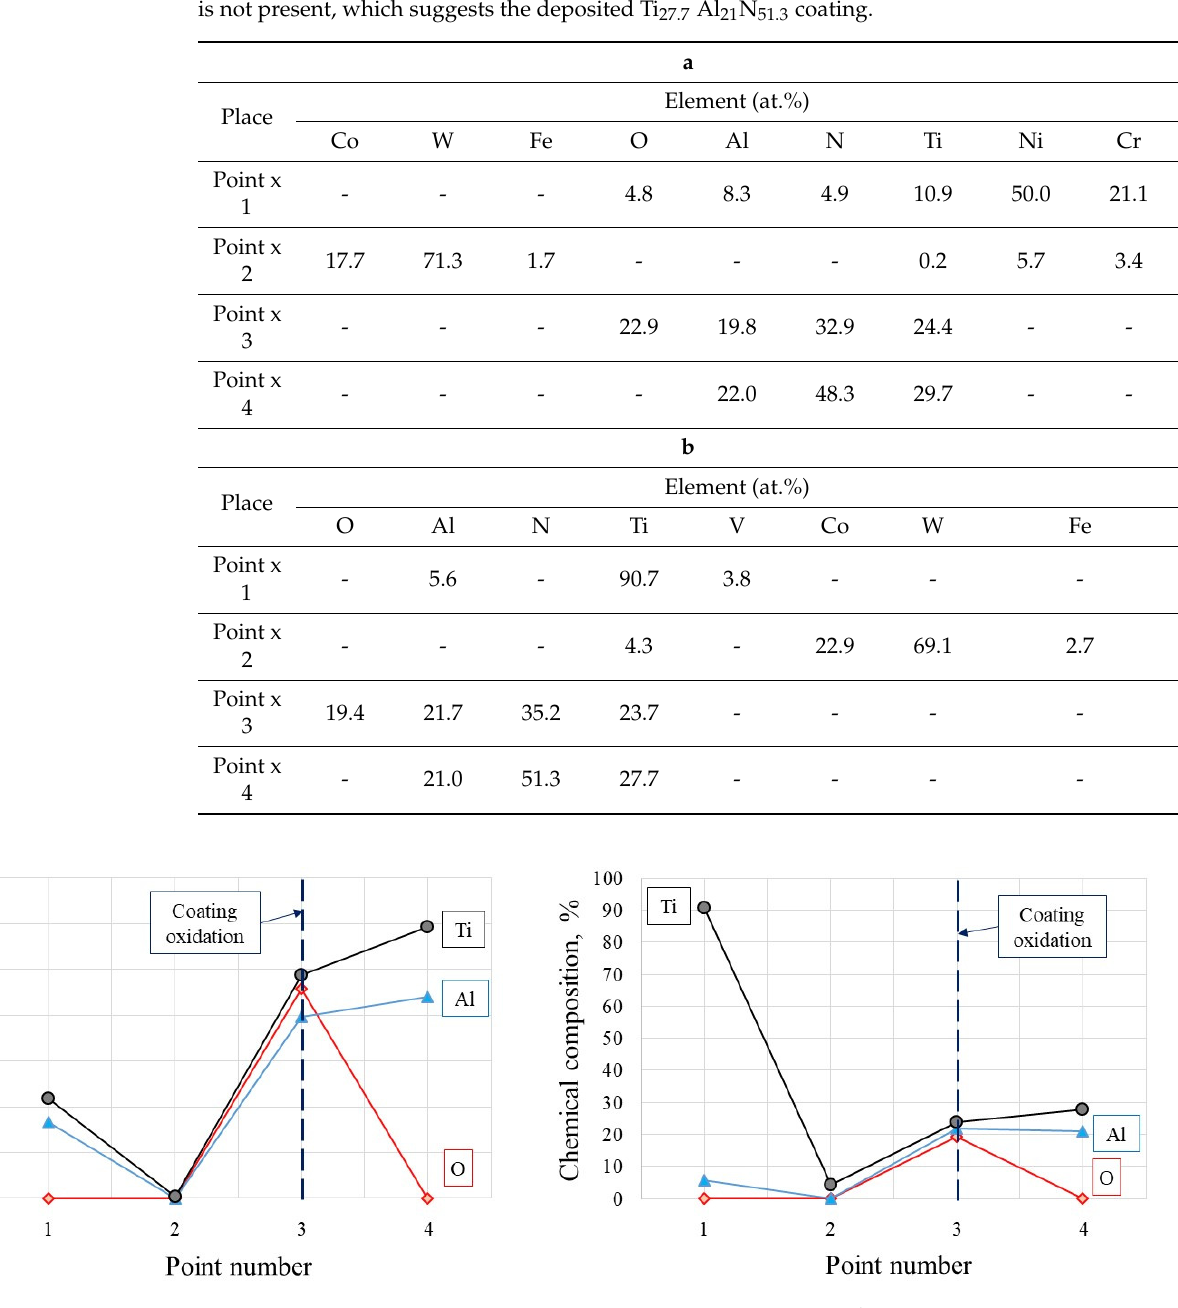
Figure 13. XRD analysis results of investigated coating after oxidation during machining tests. Table 6. a. At.% for oxidized layer produced in TiAlN + IN 718 dynamic diffusion couple at different points of the rake face in Figure 8a. Note that in point 1 the deposited workpiece material is detected, whereas in point 2 the WC-Co substrate is detected. On the other hand, in point 3 a fragment of Al 2 O 3 oxidized layer is detected. In point 4, the oxygen is not present, which suggest the deposited Ti 29.7 Al 22 N 48.3 coating. b. At.% for oxidized layer produced in TiAlN + Ti6Al4V dynamic diffusion couple at different points of the rake face in Figure 9a. Note that in point 1 the deposited Ti6Al4V (Ti 90.7 Al 5.6 V 3.8 ) workpiece material is detected, whereas in point2 the WC-Co substrate is detected. On the other hand, in point 3 a fragment of Al 2 O 3 oxidized layer is detected. In point 4, the oxygen is not present, which suggests the deposited Ti 27.7 Al 21 N 51.3 coating. a Place